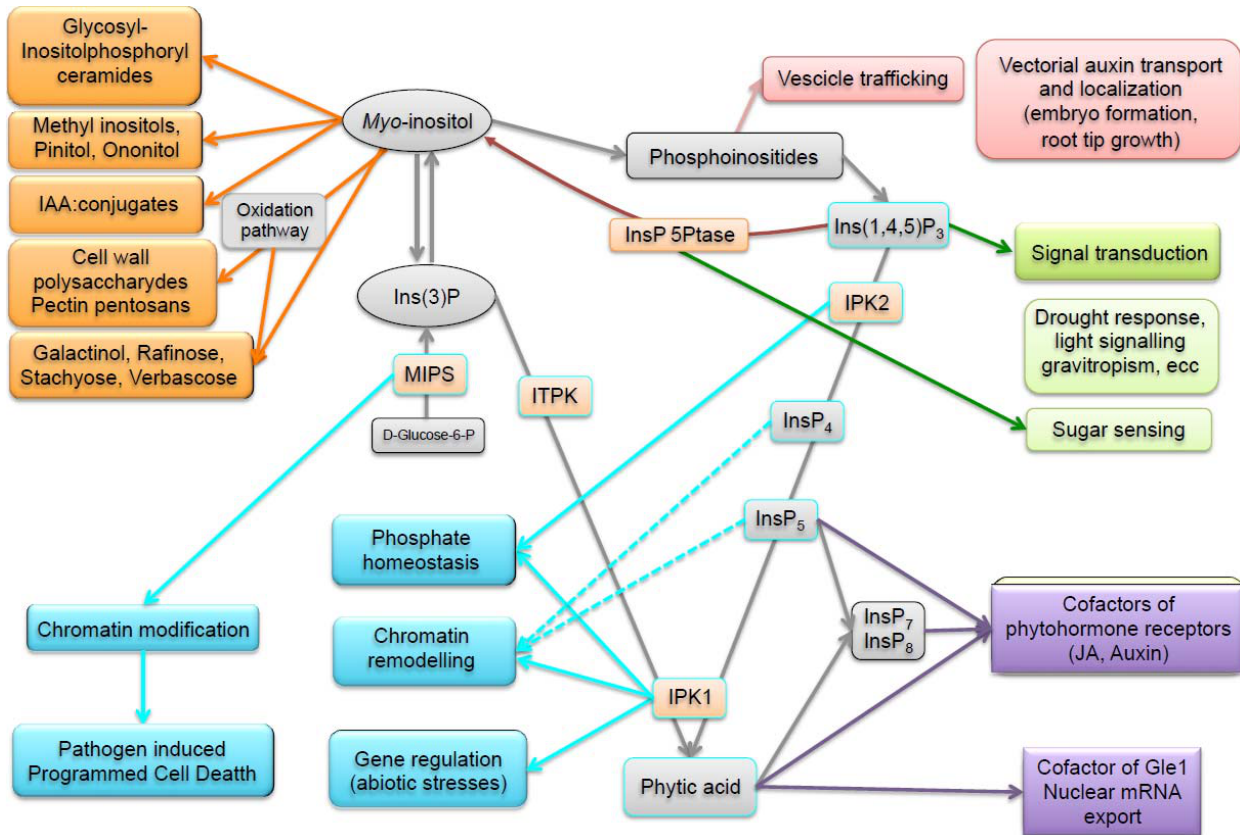
Figure 2. Scheme showing and summarizing the diverse roles of inositol metabolism and phytic acid pathway in compatible pathways (orange), signal transduction (green), membrane biogenesis and trafficking (red), gene regulation (light blue), and as cofactors of regulatory proteins (violet). Light blue boxed enzymes and metabolites have been found localized both in the nucleus and in the